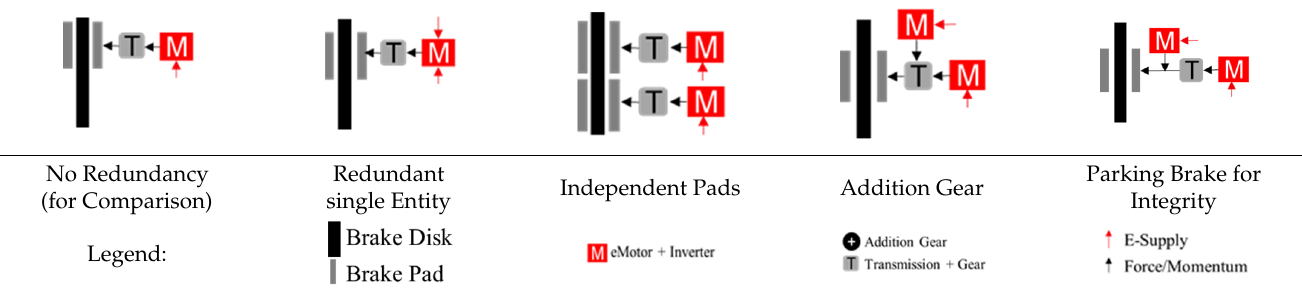
Table 6. EMB actuator redundancy concepts exemplarily shown as disk brake configurations.